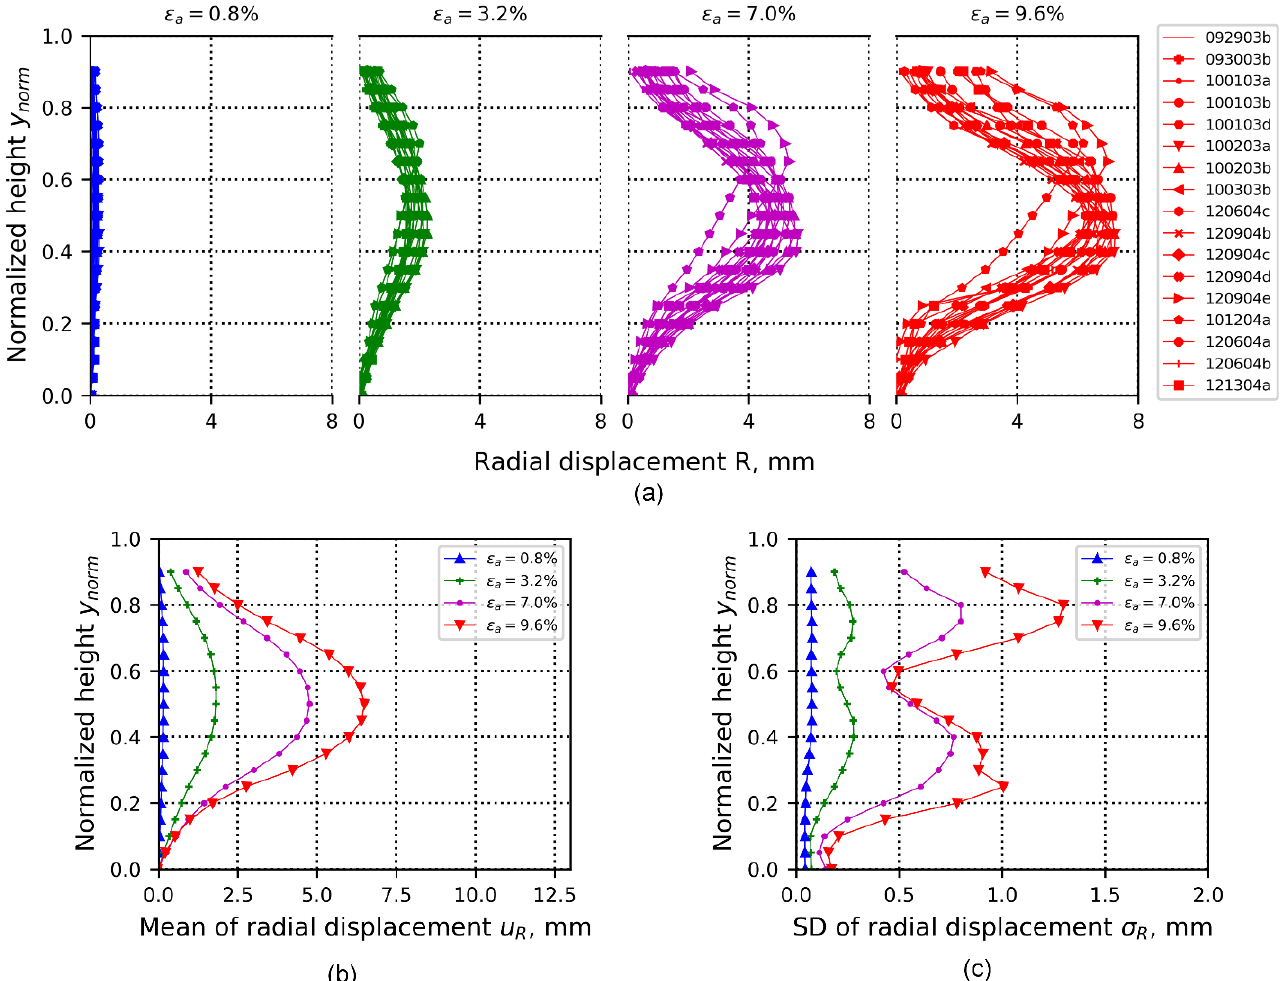
Figure 9. ( a ) 1D-T data ensembles of averaged radial displacements calculated from 17 tests at four loading stages—0.8%, 3.2%, 7.0%, and 9.6% of axial strain. The radial displacement at each specimen height is estimated through averaged radial displacements that are captured by 3D-DIC. ( b ) Mean of data ensembles shown in ( a ). ( c ) Standard deviation of data ensembles shown in ( a ).